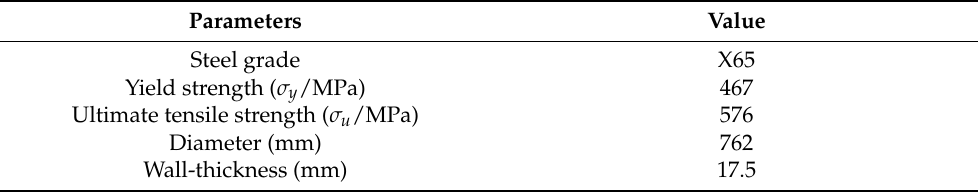
Table 1. The material properties and geometrical parameters of API 5L X65 (Date from literature [44].